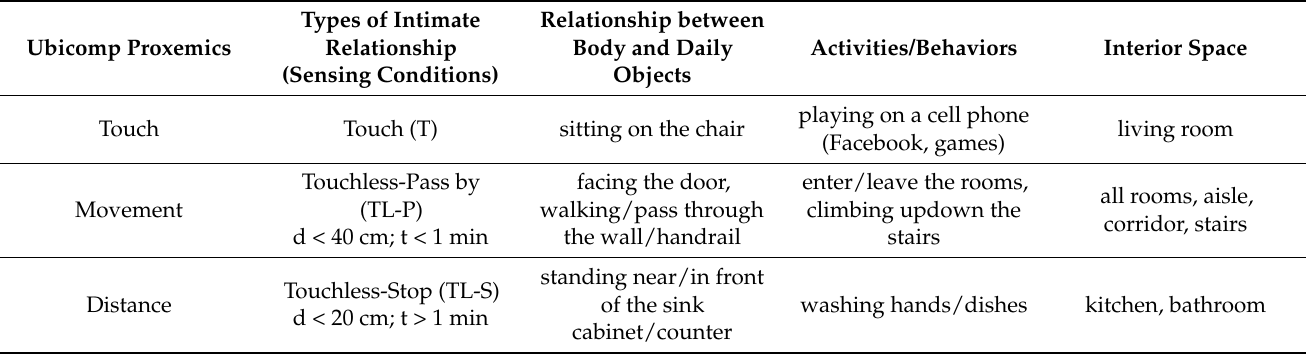
Table 2. Sensing conditions and the relative activity